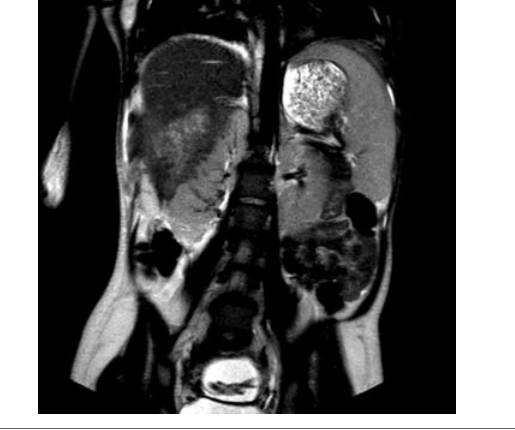
Figure 1. Non-contrast magnetic resonance imaging of abdomen and pelvis: heterogeneous mass 11.2×7.7 cm arising from right kidney extending to liver edge, splenomegaly with spleen meas- uring 15.2 cm and mild right hydronephrosis.